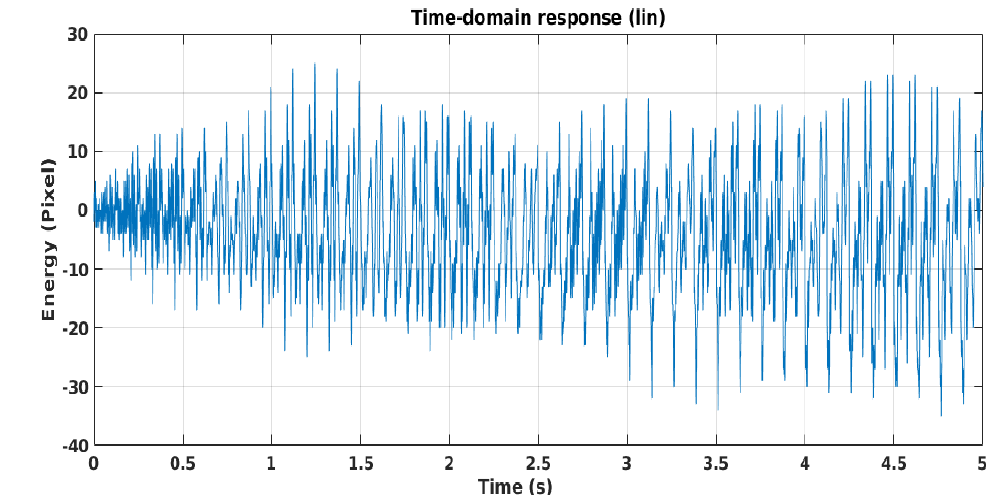
Figure 14. Temporal trend of vibrations.